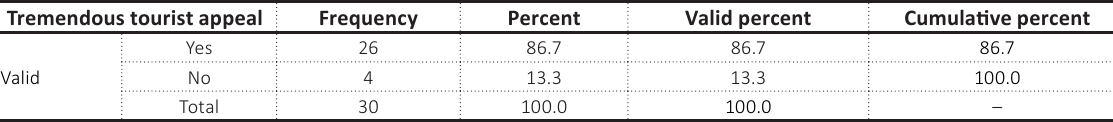
Table A3. Tremendous tourist appeal about local culture